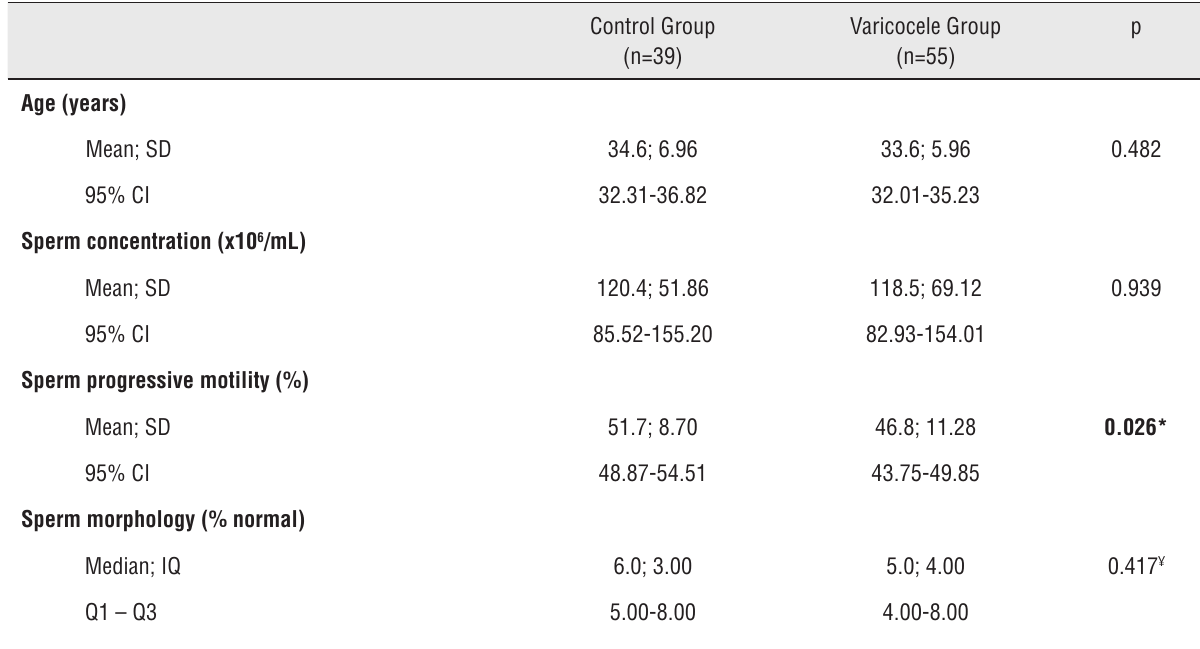
Table 1 - Clinical and semen analysis data of the control and varicocele groups. Groups were compared using an unpaired Student’s T test ( α =5%), unless otherwise